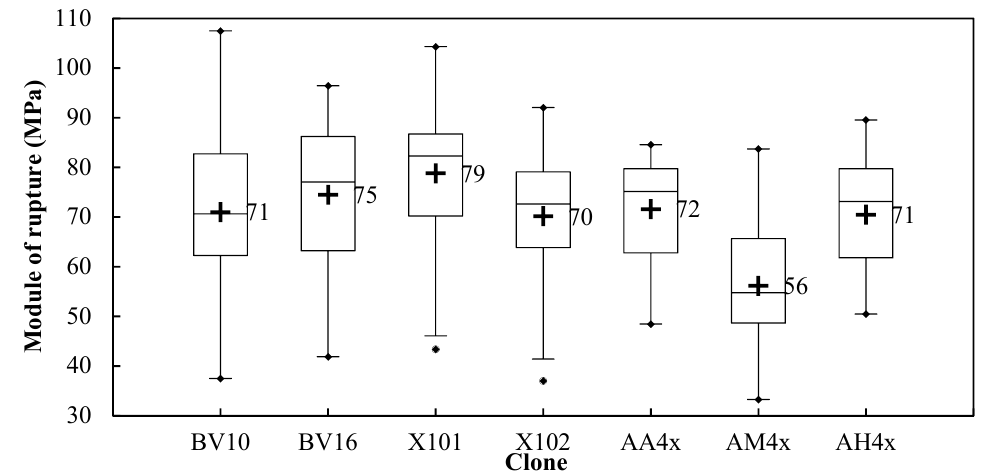
Figure 8. Variation of module of elasticity (GPa).